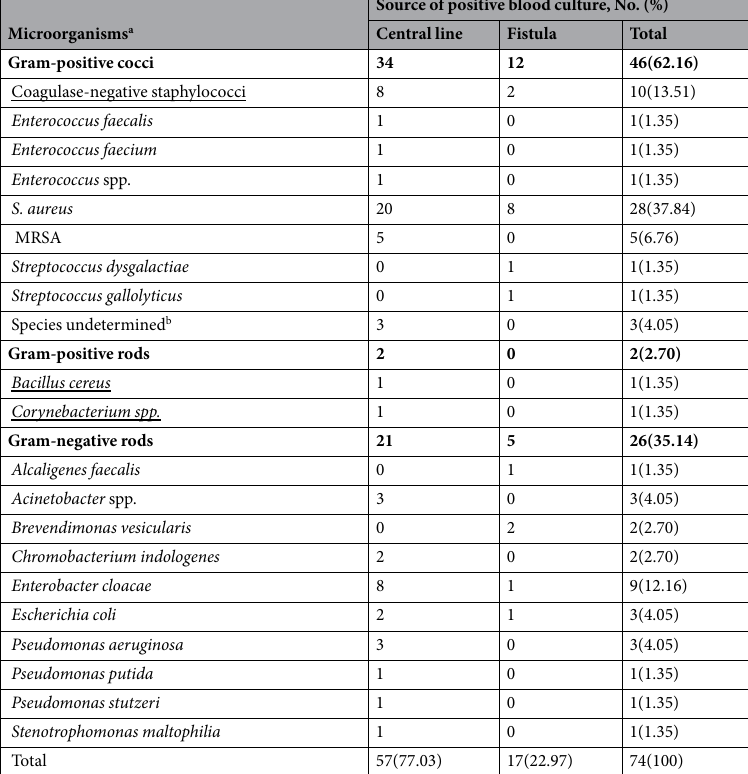
Table 4. Microorganisms recovered from blood cultures. a Those belonged to the skin commensal microflora are underlined. b The isolates were identified as Gram-positive cocci by Gram stain but the species identification was not